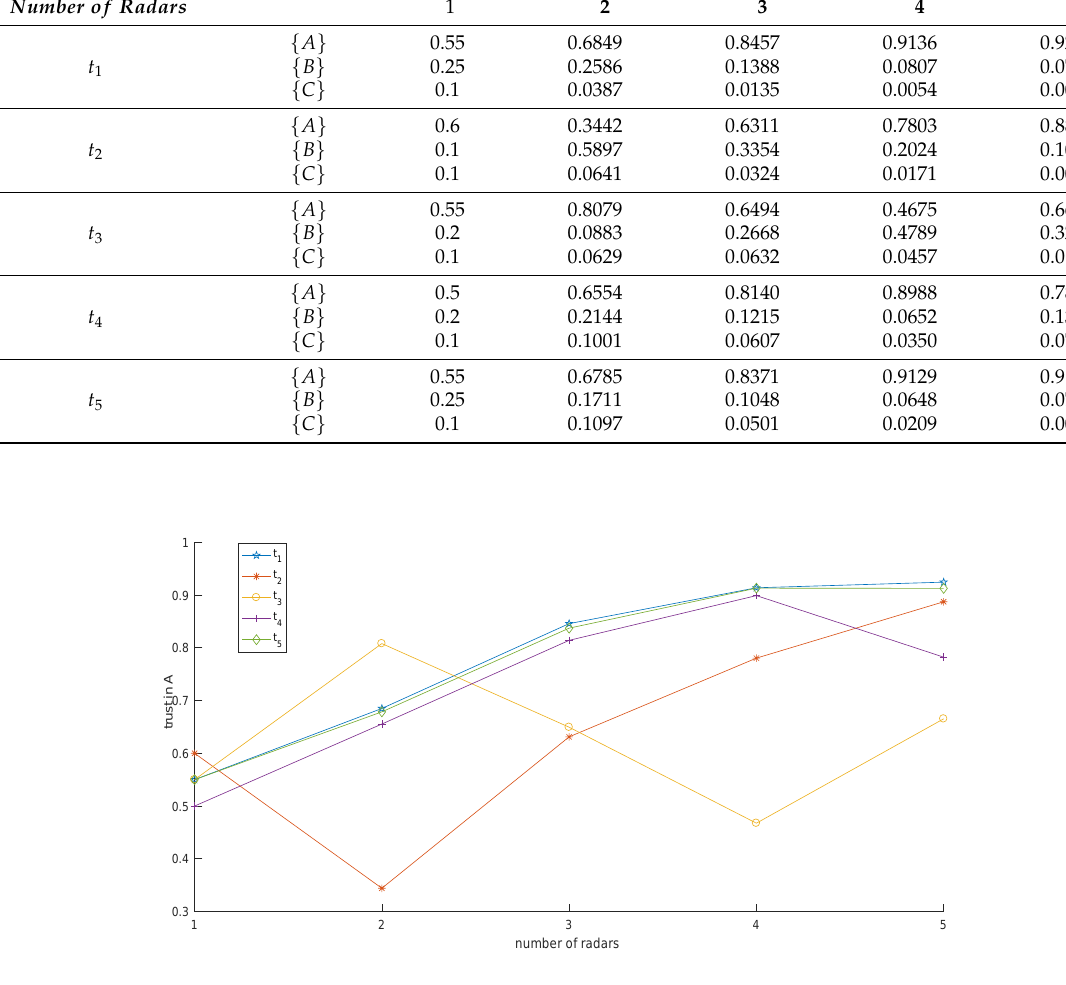
Figure 12. The trend of fusion results from different numbers of